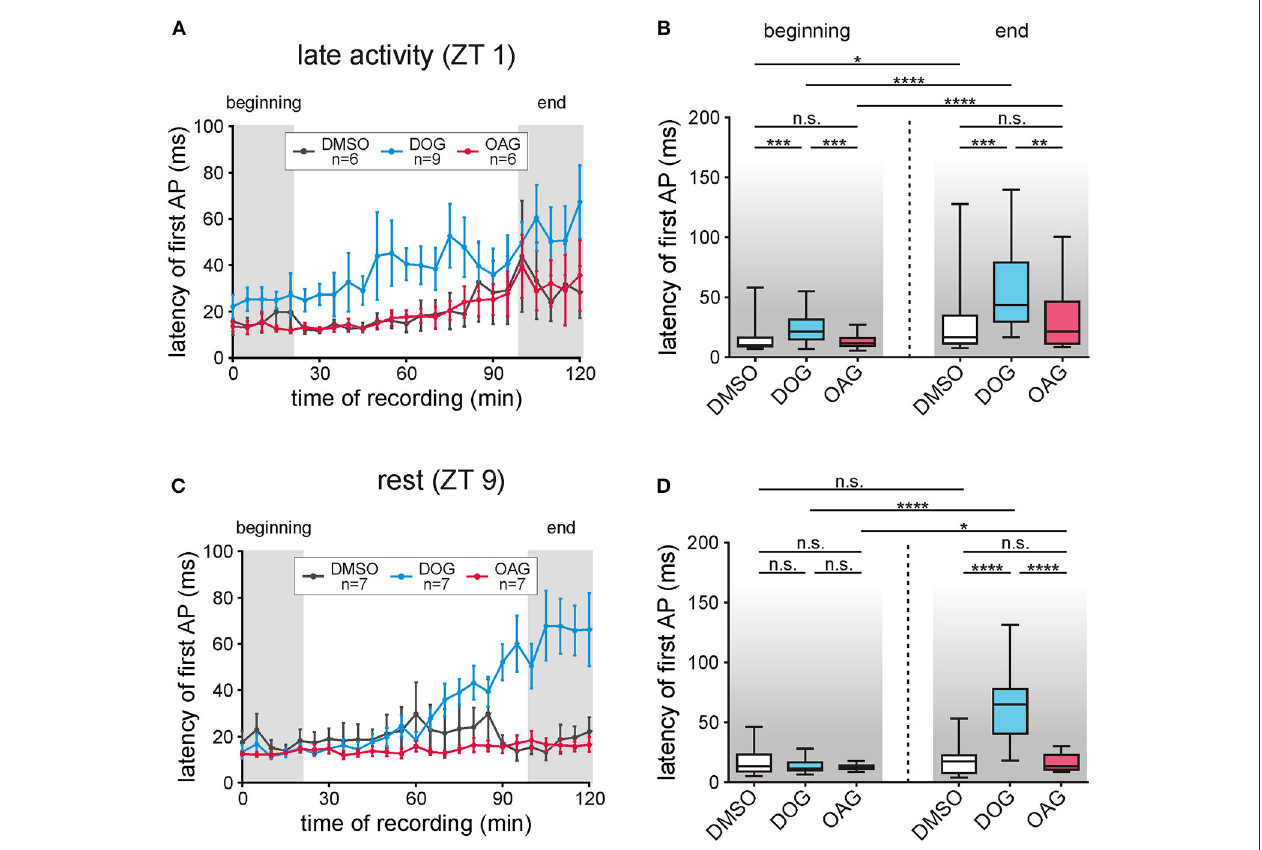
FIGURE 7 | The latency of the first bombykal-dependent action potential (AP) increased only with DOG infusion. (A,B) During the late activity phase the latency of the first pheromone-dependent AP increased during the course of time in control recordings with 0.1% DMSO ( n = 6) as well as with application of 100 µ M DOG ( n = 9) or 100 µ M OAG ( n = 6). In comparison to the controls only DOG significantly increased the latencies while application of OAG showed no significant differences. (C,D) In control recordings during rest ( n = 7) no changes in the latency occurred during the course of the recordings and only a small increase was found under the influence of OAG ( n = 7). However, application of DOG strongly and significantly increased the latency of the first AP in the last 20min of the recordings (for exact P -values see Table 4 ; for mean values ± SEM see S6. n.s. = not significant; * P < 0.05; ** P < 0.01; *** P < 0.001; **** P < 0.0001; Wilcoxon test, Mann-Whitney test or Kruskal-Wallis test with Dunn’s post-hoc test for multiple